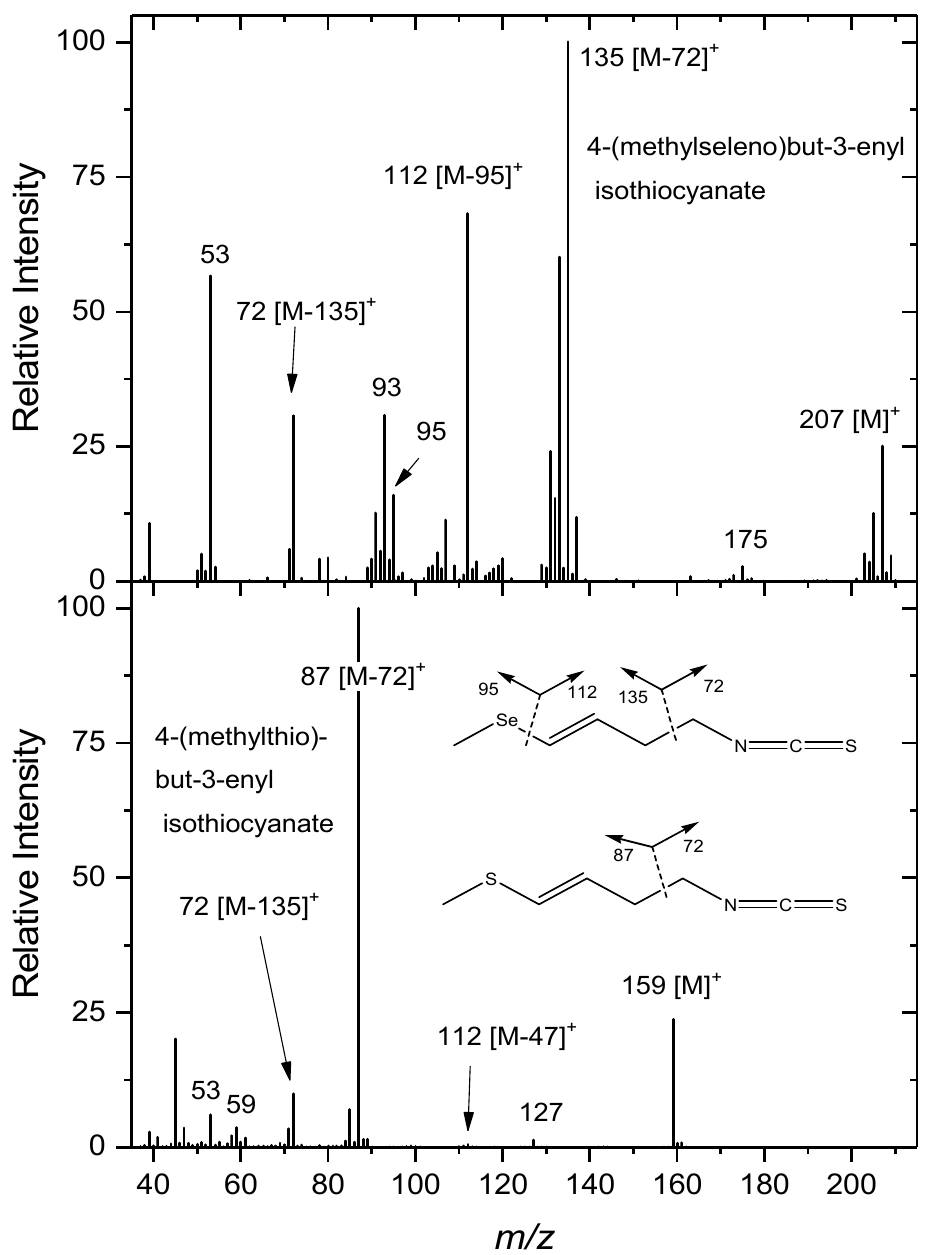
Figure 5. Comparison between the electron impact mass spectral fragmentation patterns of 4-MTB3-ITC and its proposed selenium analogue 4-MSeB3-ITC.